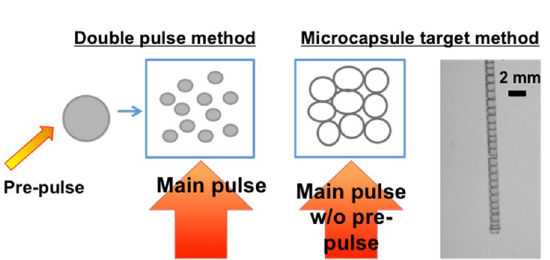
Figure 5. Scheme comparing current EUVL double-pulse method (left) to the proposed microcapsule aggregate target (right). The aggregate would represent a “mist” in a similar manner to current methods requiring two pulses. A high-speed camera image shows some progress at Tokyo Tech to date. The microcapsules can be produced in a large volume, which could be used for continuous target